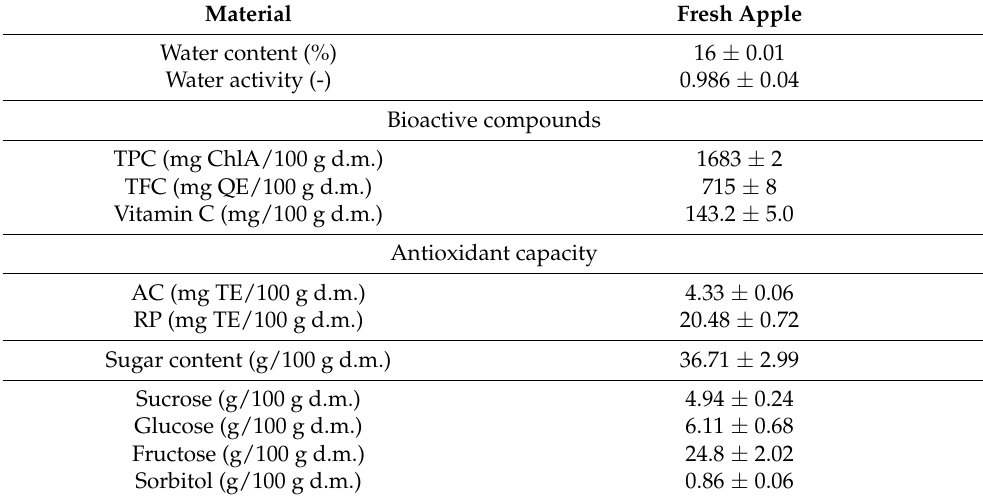
Table 1. Properties of the fresh apple sample.